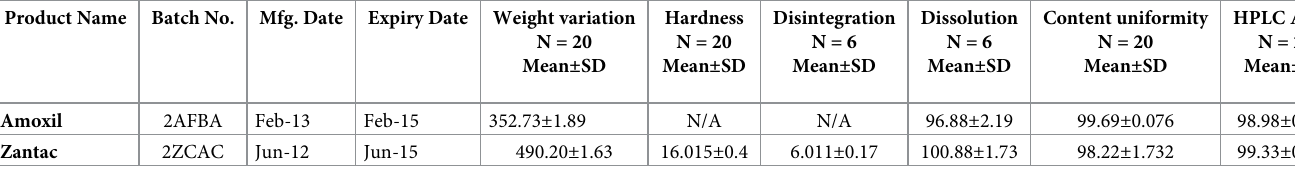
Table 1. Physicochemical attributes of amoxicillin and